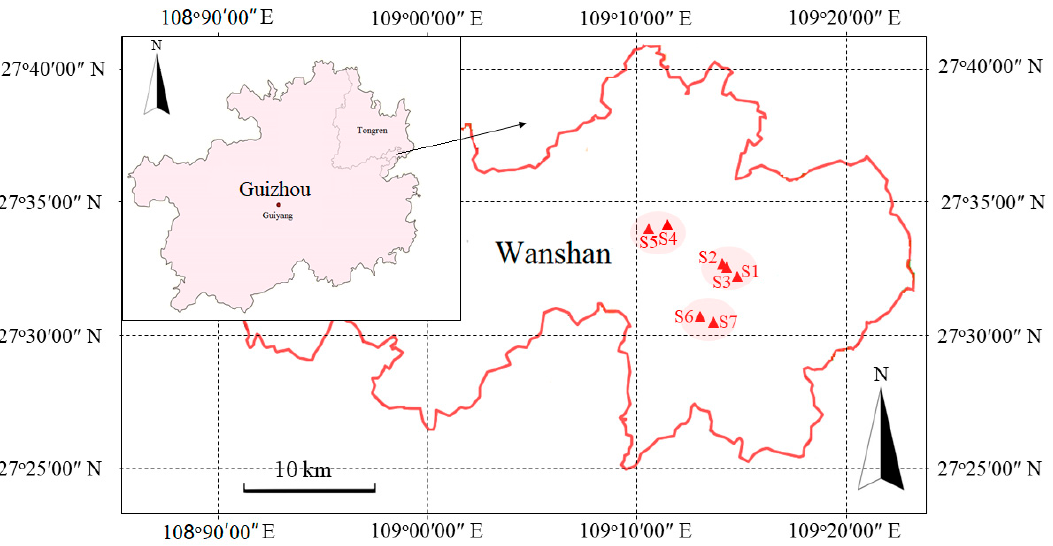
Figure 1. All sampling sites in the Wanshan Hg mine area of Guizhou province are indicated with triangles. The small map shows the location of the Wanshan district in Guizhou Province, China. The large map shows the layout of each sampling point.